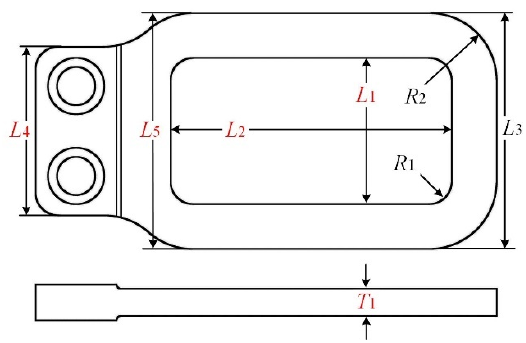
Figure 14. Schematic of the design variables’ location.